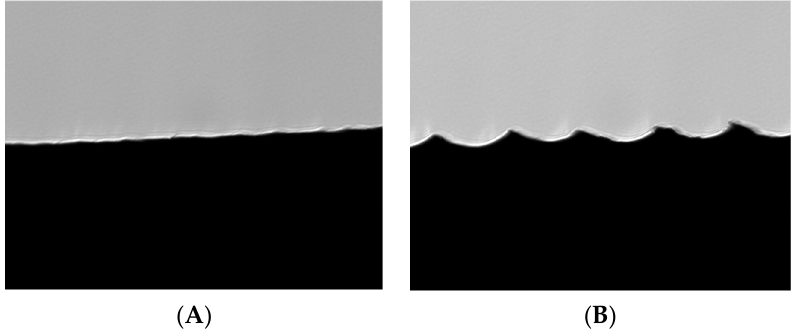
Figure 3. Acquired images of the edge of sample 5 ( A ) of R a = 2.4 µm and sample 7 ( B ) of R a = 15.1 µm. Full image size is 2448 × 2048 pixels corresponding to 1.4 × 1.7 mm.